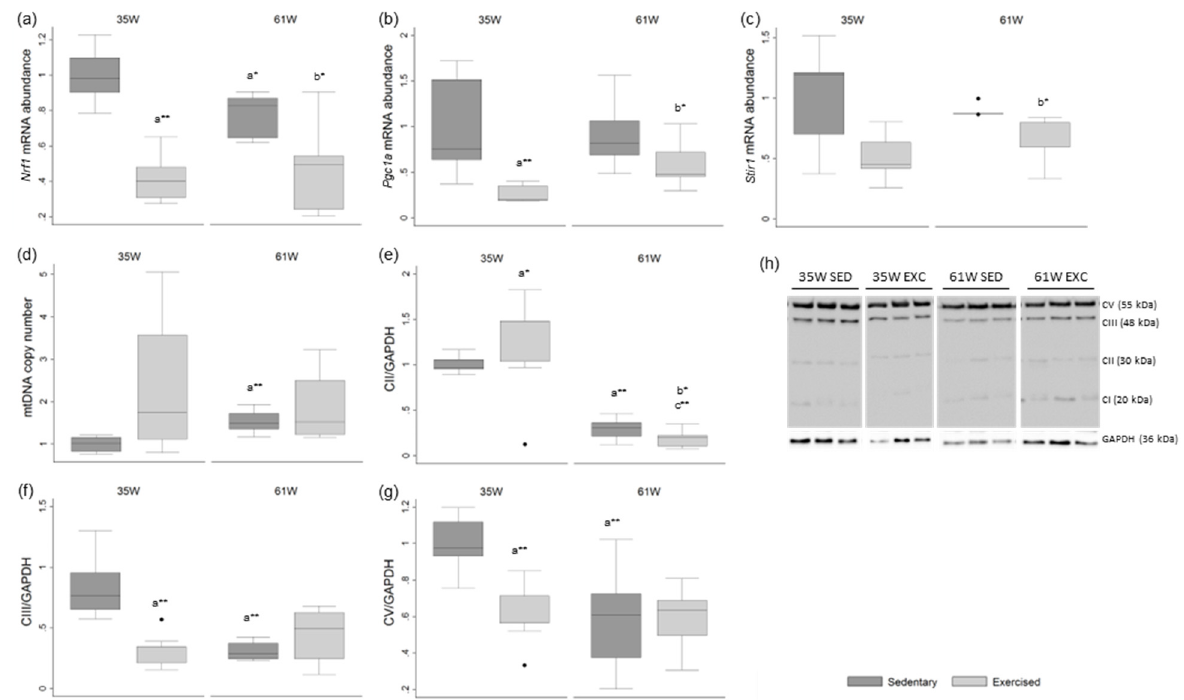
Figure 2. Box and whisker plots show the effect of age and exercise training on ( a ) nuclear respira- tory factor 1 ( Nrf1 ), ( b ) peroxisome proliferator-activated receptor gamma coactivator 1 α ( Pgc1a ), ( c ) Sirtuin 1 ( Sirt1 ) mRNA abundance in rat testis. Quantification of mtDNA abundance ( d ) in rat testis was also performed. The protein levels of mitochondrial respiratory chain complexes II, III and V are represented in ( e – g ), respectively. ( h ) Representative Western blot images of mitochondrial respiratory chain complexes II, III and V and GAPDH. CI: NADH dehydrogenase (ubiquinone), 1 beta subcomplex, subunit 8; CII: succinate dehydrogenase complex, subunit B, iron sulfur; CIII: ubiquinol- cytochrome c reductase, core protein II; CV: ATP synthase alpha-subunit. GAPDH was used as the protein-loading control and the results are represented in fold variation to control. The horizontal line displays the median, the box edges show the 25th and 75th percentiles and the whiskers show the smallest and highest value within 1.5 box lengths from the box ( n = 8 for 35 W Sedentary; n = 9 for 35 W Exercised, 61 W Sedentary and 61 W Exercised). * p < 0.05; ** p < 0.01. a—Significantly different from 35 W Sedentary; b—significantly different from 61 W Sedentary; c—significantly different from 35 W